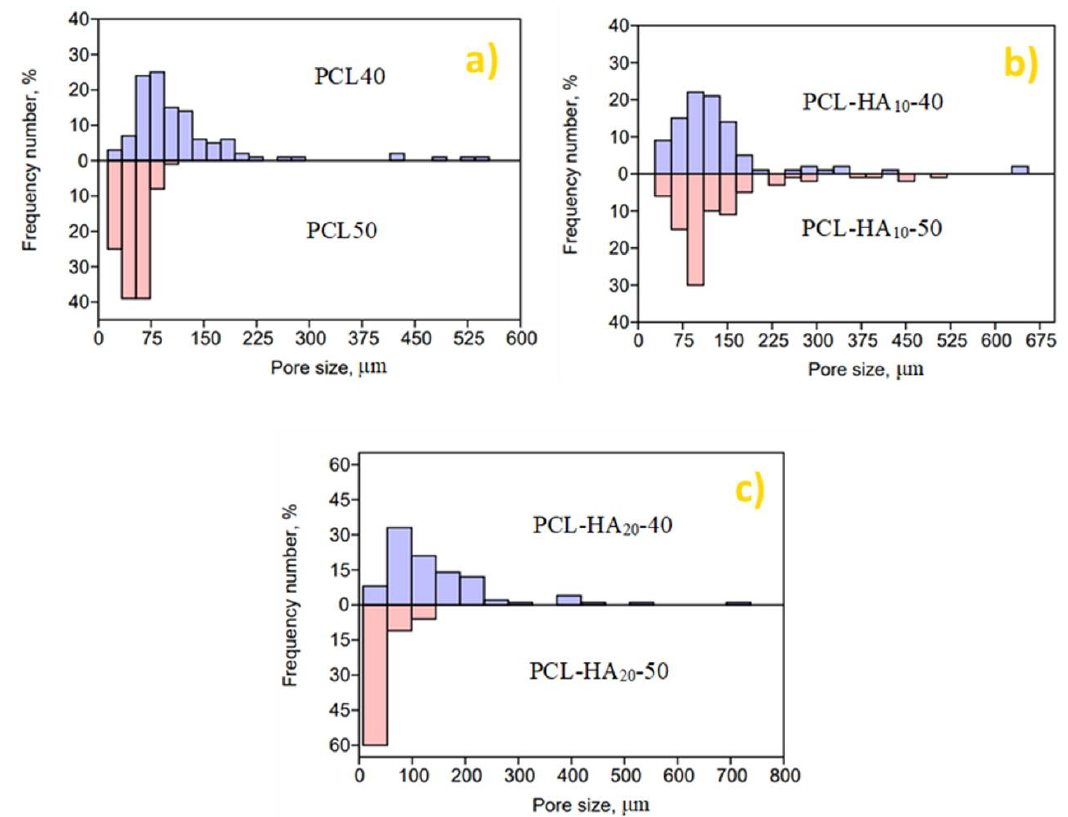
Figure 11. Pore size distribution of the PCL scaffolds after impregnation with carvacrol: neat PCL